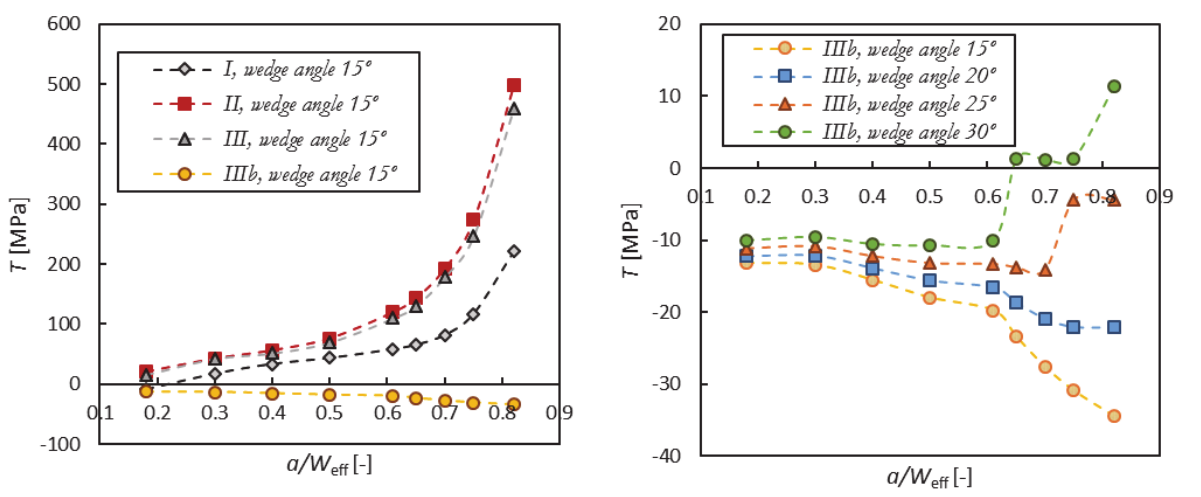
Figure 5: T -stress as function of the relative crack length,  , for the combined bending/splitting variants defined in Fig. 1, loaded by P sp = 1000 N, on the left side for wedge angle =15° and on the right side for variant IIIb for various wedge angles.